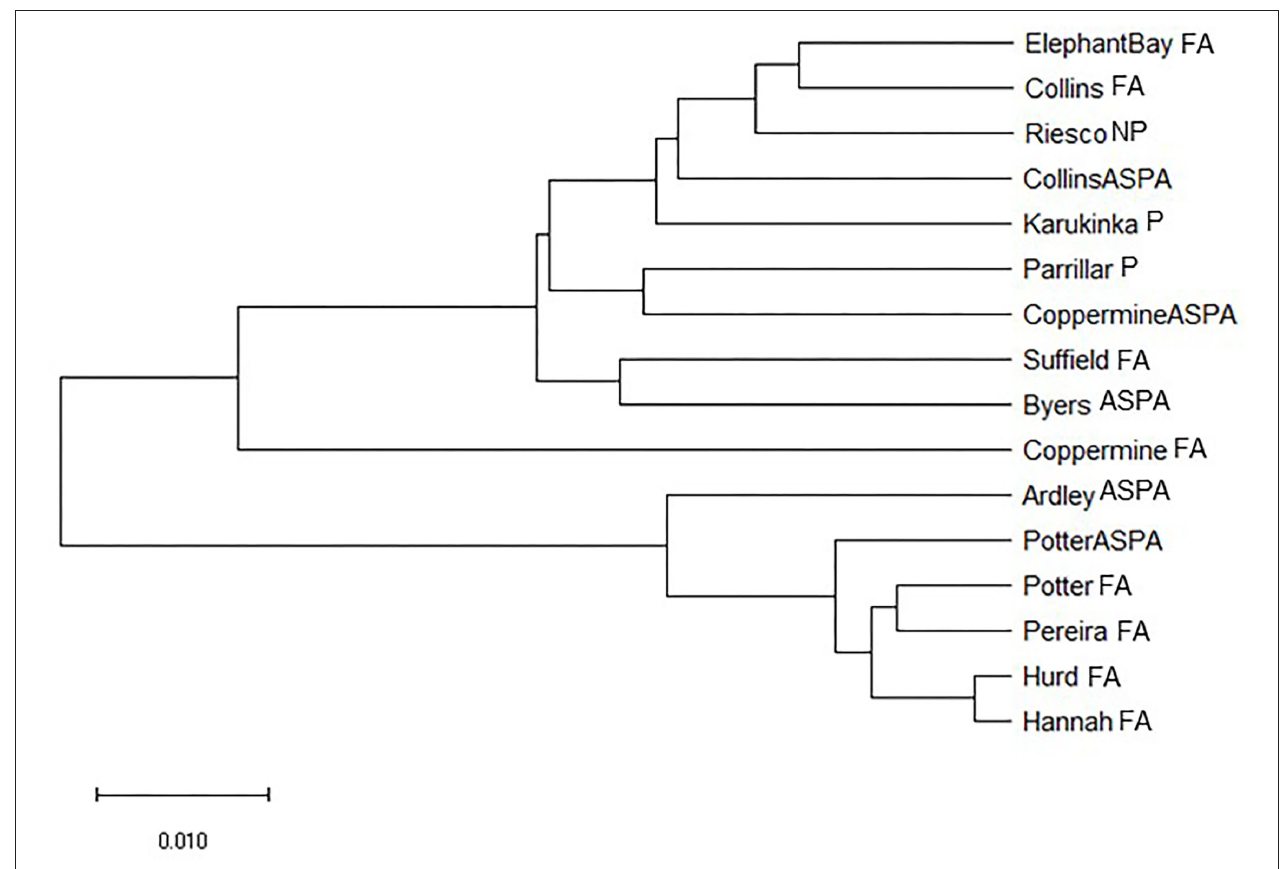
FIGURE 4 | A neighbor-joining tree of relatedness of Sanionia uncinata populations from Antarctica and southern